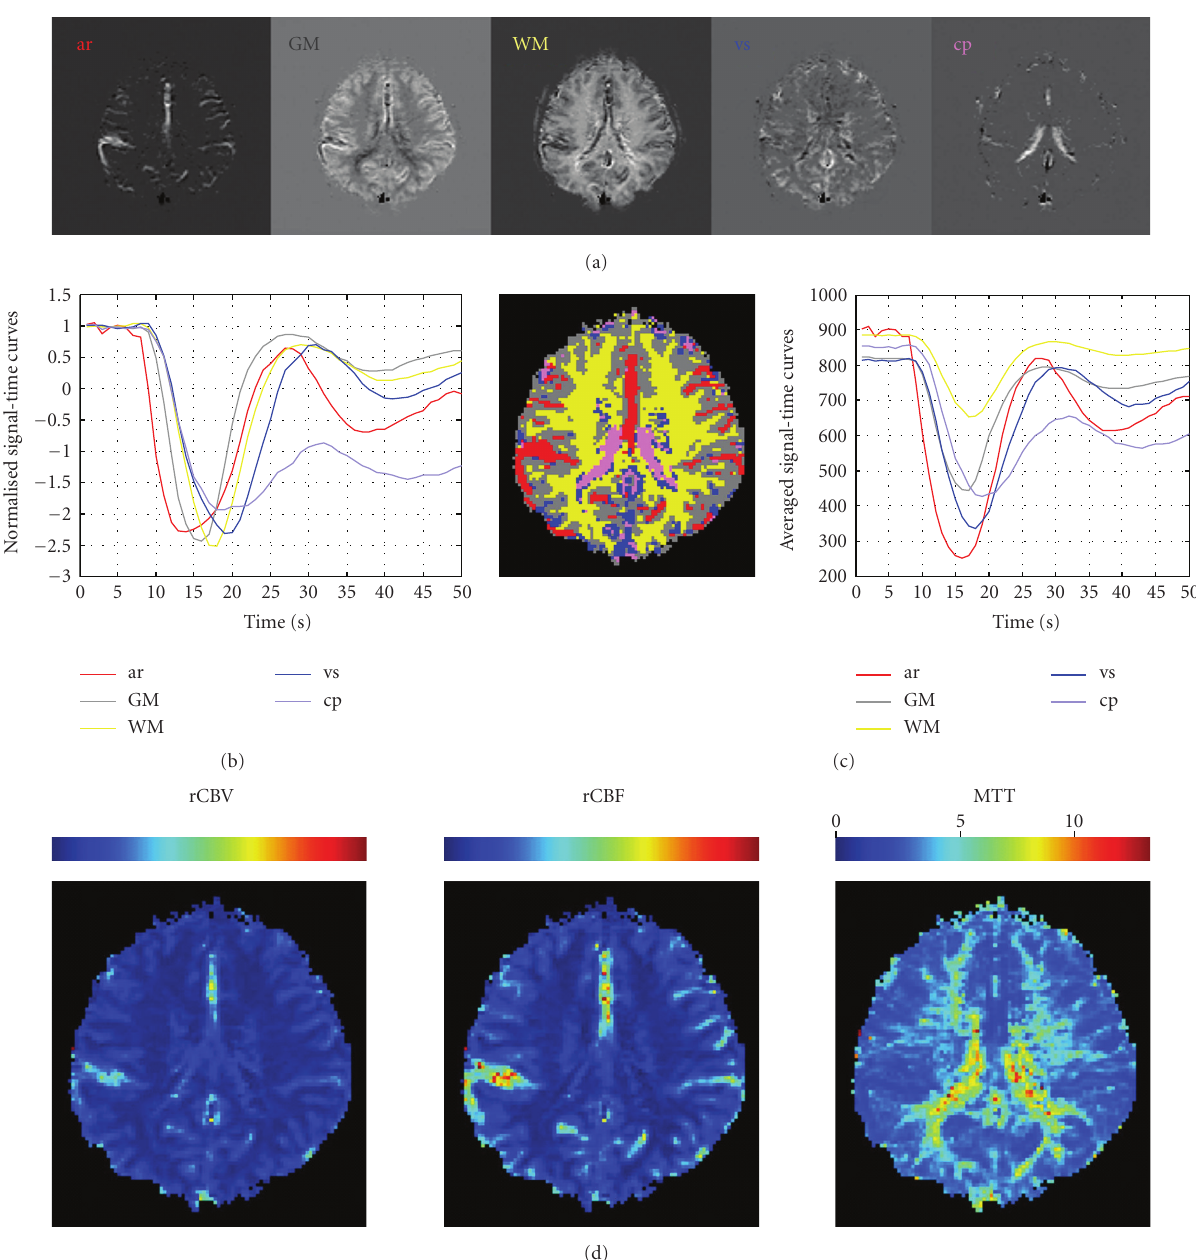
Figure 3: Classification results of a normal subject (whose perfusion images are shown in Figure 1). (a) Five major tissue types exhibited in IF images are ar, GM, WM, vs, and cp, respectively. (b) The normalized signal-time curves correspond to five IF images, where the one (red) with the fastest signal drop is the artery. (c) Left: a color-coded composite map is used to represent the final segmentation result for di ff erent tissue types. Right: five signal-time curves correspond to the averaged intensities of color-coded areas. (d) The rCBV map (left), the rCBF map (middle), and the MTT map (right). (Scale unit for rCBV and rCBF: arbitrary unit; scale unit for MTT: second.)